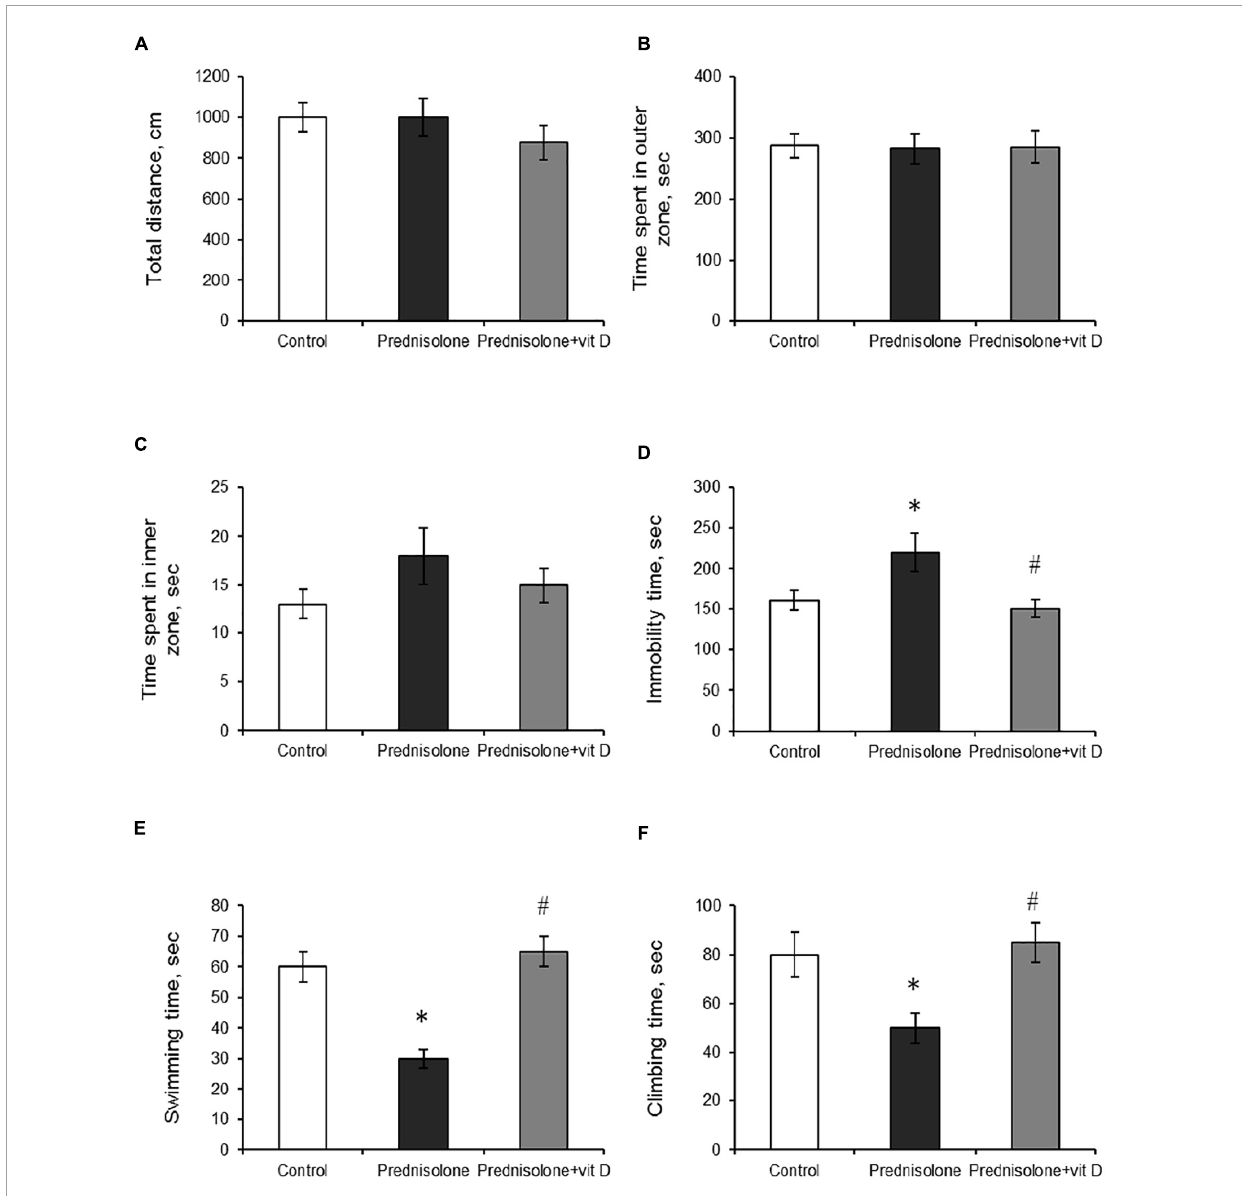
FIGURE3 The influence of prednisolone and vitamin D 3 on the parameters of the open field (OFT) and forced swim (FST) tests. Animals from three experimental groups: 1—control; 2—prednisolone administration; 3—prednisolone and vitamin D 3 administration ( n = 8 rats/group) were subjected to the OFT (A–C) and FST (D–F) . Total distance traveled (A) , time spent in outer (B) and inner (C) zones were calculated during the OFT. Total immobility time (D) and the parameters of active behavior: swimming (E) , and climbing (F) were assessed during the FST. All data are presented as mean ± SD of three independent experiments done in triplicate; ∗ p < 0.05 denotes significance compared with control, # p < 0.05 denotes significance compared with prednisolone